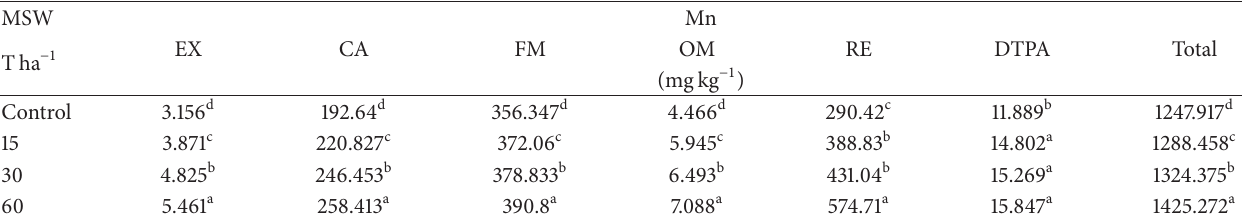
Table 3: Mean comparison of total and DTPA-extractable concentrations and existing amounts in 5 different soil fractions for Mn, respectively, at different levels of